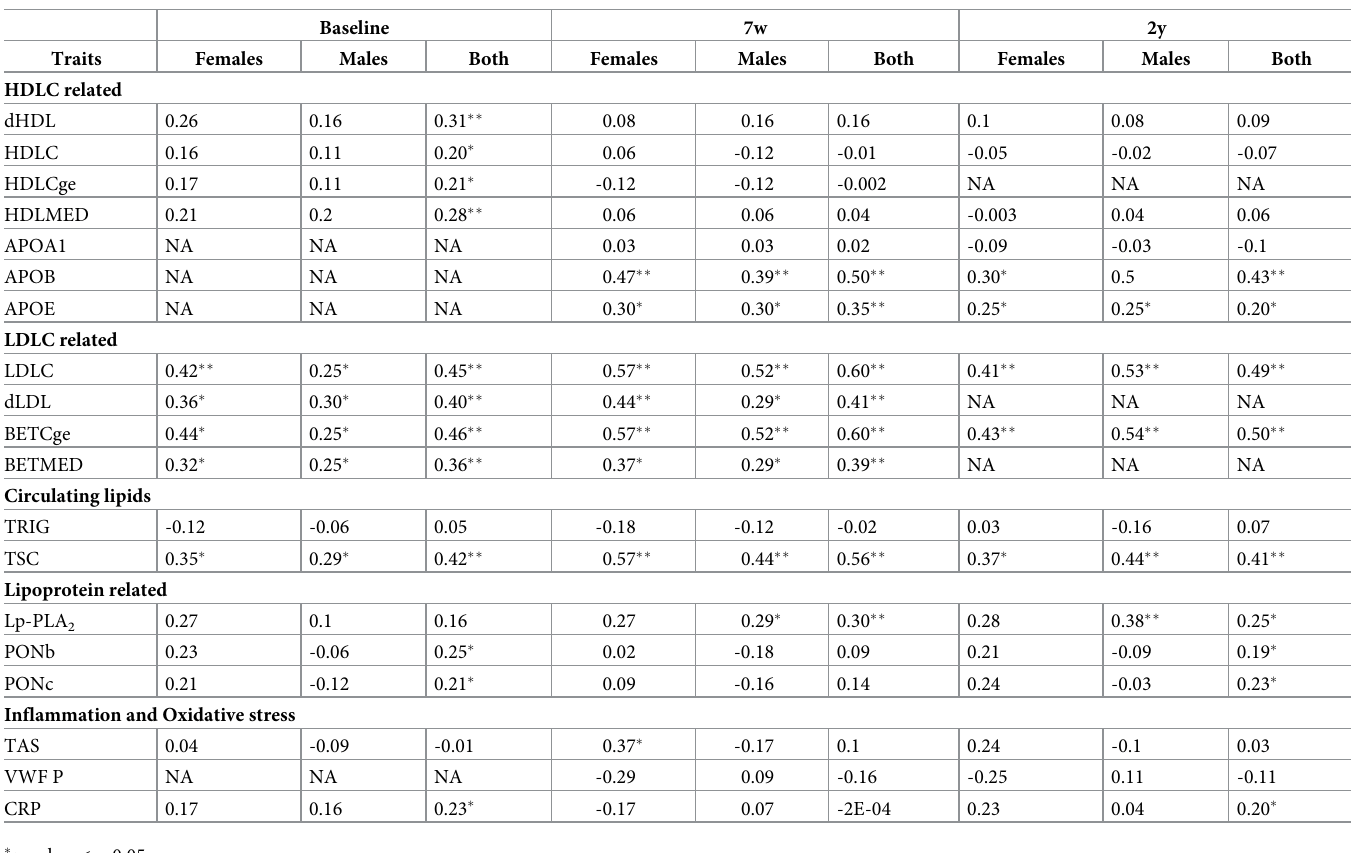
Table 2. Correlations of clinical traits with total lesion